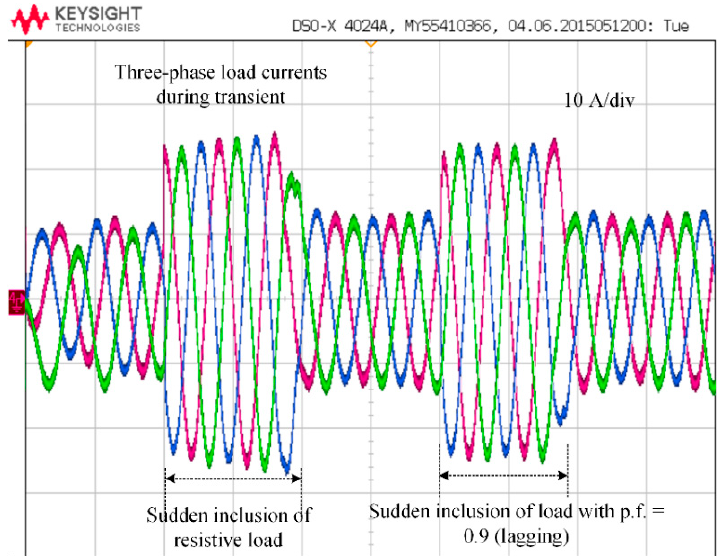
Figure 20. Three-phase load currents under sudden load change.